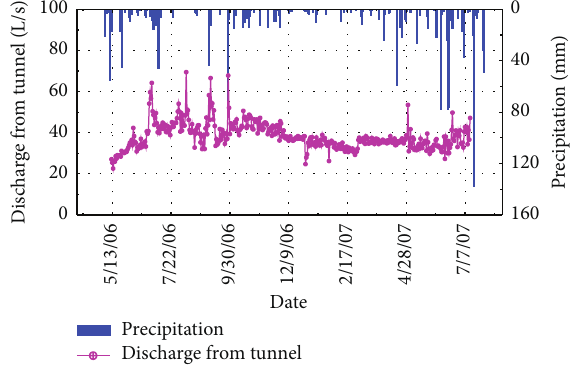
Figure 6: Drainage from tunnel versus